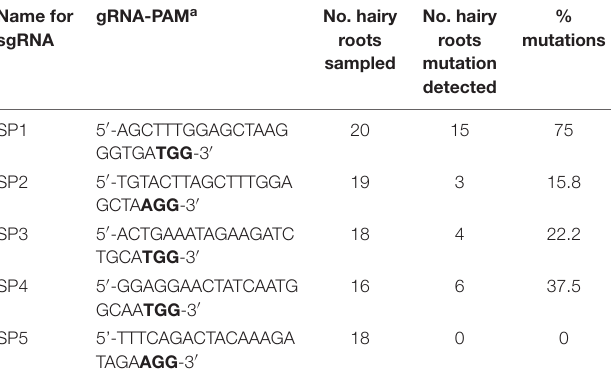
TABLE 1 | Summary of mutations generated for each sgRNA.